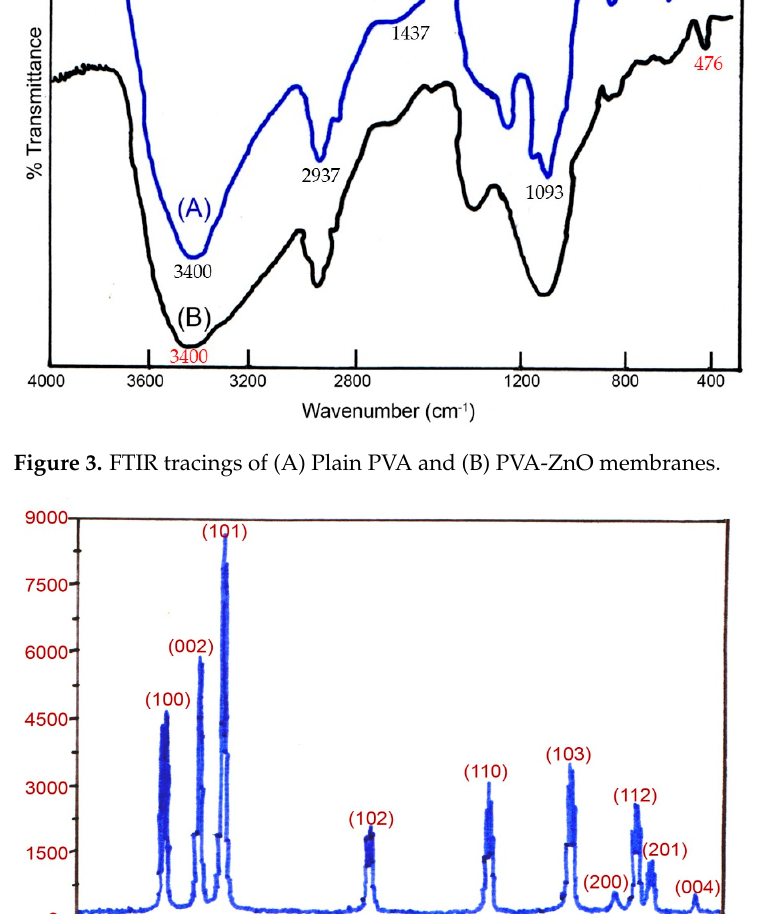
Figure 5. SEM images of ( A ) Plain PVA, ( B ) PVA ‐ ZnO ‐ 2.5 %, ( C ) PVA ‐ ZnO ‐ 5 and ( D ) PVA ‐ ZnO ‐ 7.5 % membranes.